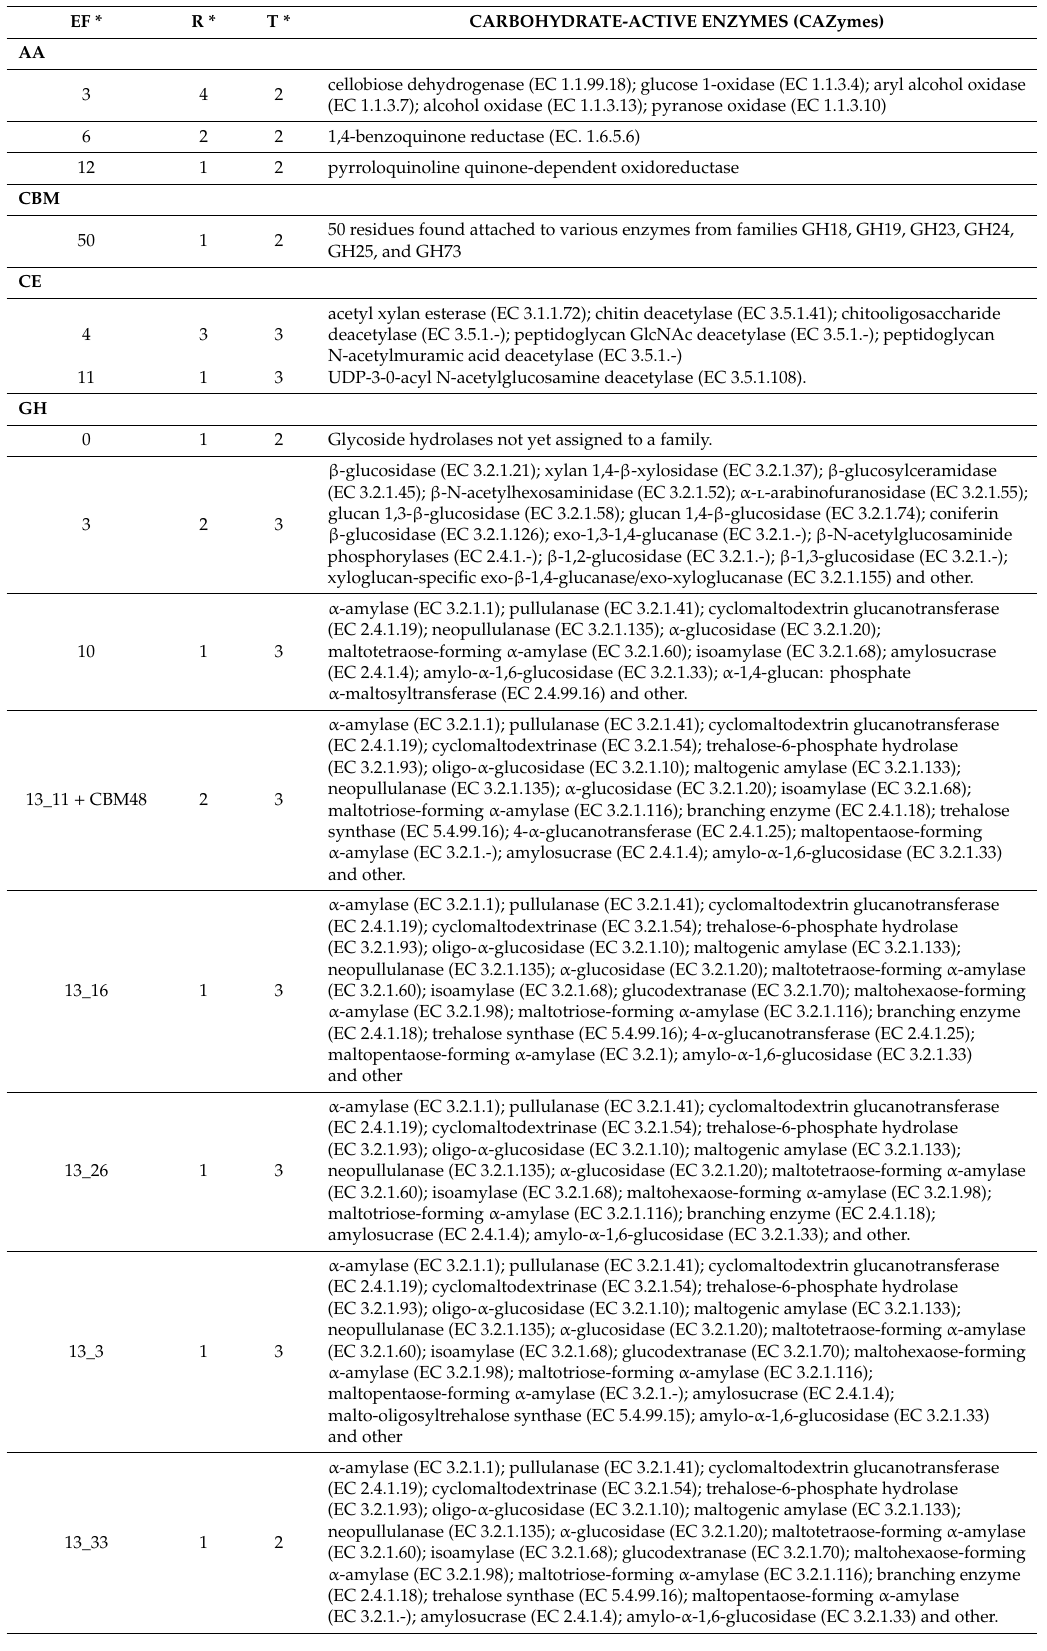
Table 4. dbCAN2 matches for strains CA3A T , C2L11, and C2L12B. EF * = Enzymatic Family, R * = Number of times the EF was predicted, and T * = No. of tools that predicted this